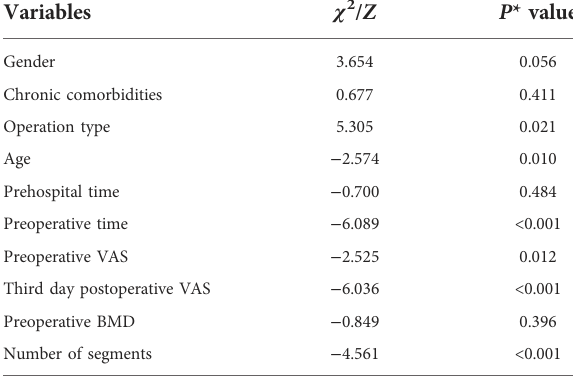
TABLE 2 Univariate analysis of factors for delayed discharge.